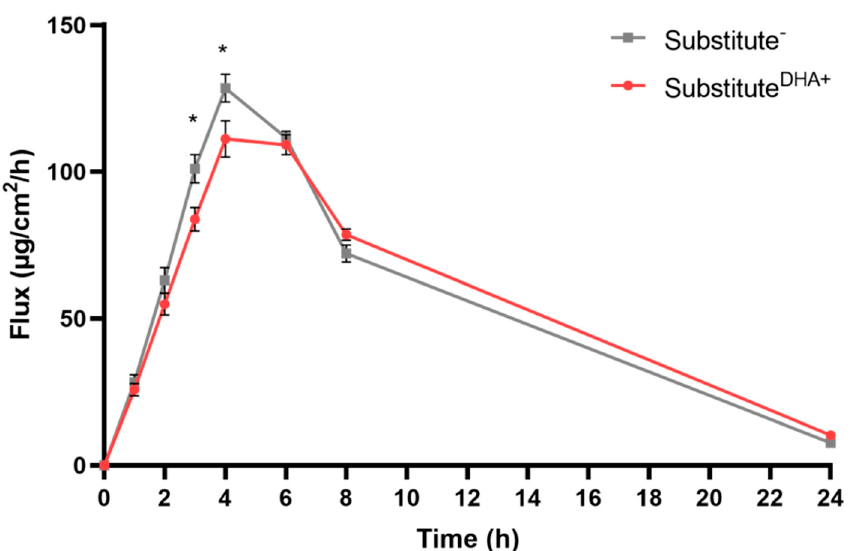
Figure 2. Testosterone permeability through skin substitutes with or without DHA supplementa- tion of culture media. The Franz cell diffusion system was used to perform percutaneous absorption studies. The testosterone dosing solution was freshly prepared in ethanol/water (1:1), yielding a concentration of 4.0 mg/mL. Quantification was done with a Waters Acquity UPLC. Values are mean +/ − standard error of the mean (SEM). n = 6 (3 donors, 2 skin substitutes per donor); p-values were derived from Student’s t -tests. * p < 0.05.